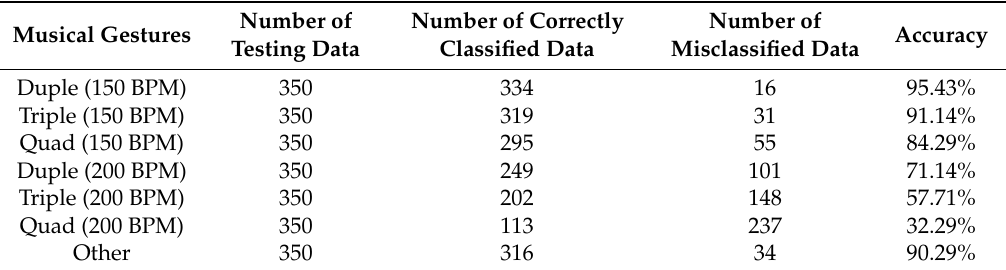
Table 3. Accuracy of musical conducting gesture recognition classified by BPM.